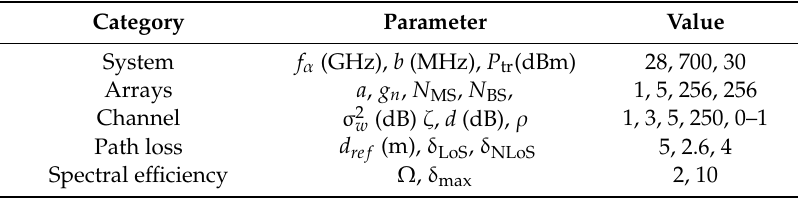
Table 1. System Table 1. System parameters.